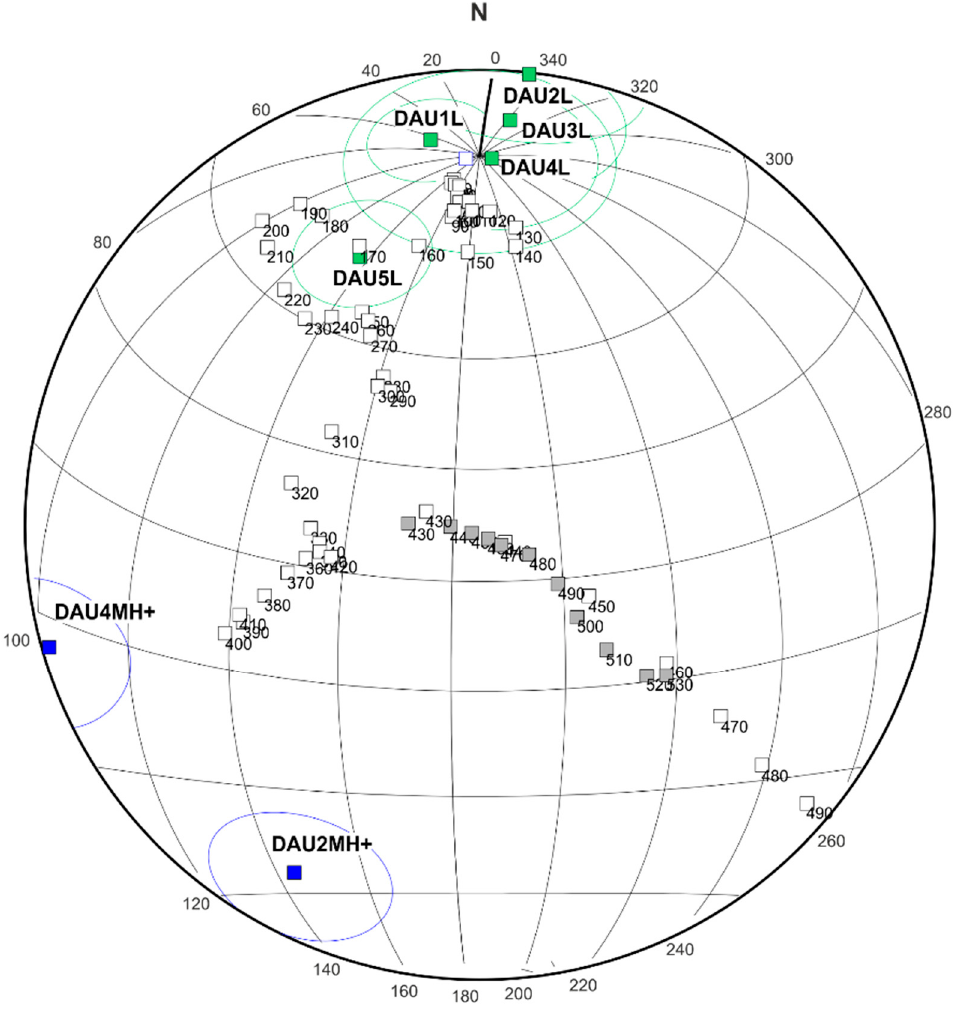
Figure 13. Schmid projection of VGPs calculated for all site mean components with κ > 10, α 95 < 17° identified in SW Oscar II Land metabasic rocks with their ovals of the confidence limit α 95 against reference path of Laurussia (open squares, palaeopoles 0–430 Ma), Baltica (open squares, palaeopoles 440–530 Ma) and Laurentia (filled squares, palaeopoles 440–530 Ma); reference palaeopoles was taken from Torsvik et al. [48]; ages of particular palaeopoles are given.